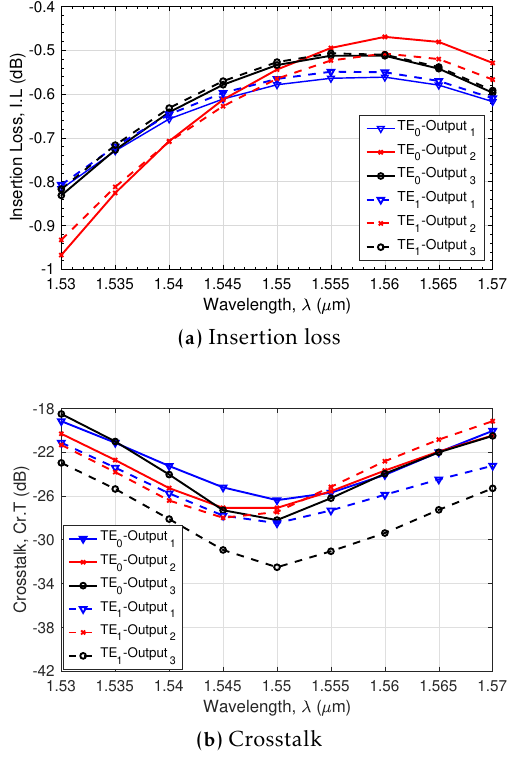
Figure 7. Insertion loss (a) and crosstalk (b) of the proposed switch as a function of the operation wavelength for TE mode (a-c) and TE TE 1 modes at three 0 1 and (h) TE . The color 0 1